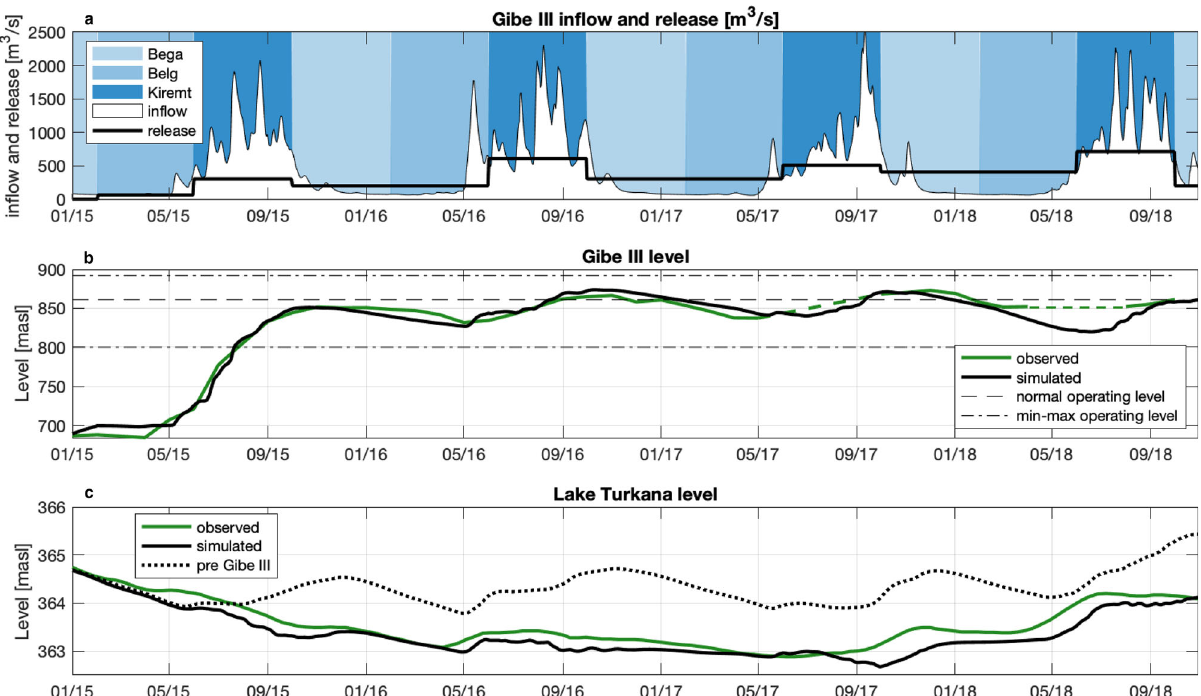
Fig. 2 Reconstructed historical fi lling strategy. a Gibe III reservoir reached its normal operating level within its fi rst two years of operations by impounding the near totality of the 2015 Kiremt season in fl ow, and a signi fi cant fraction of 2016 ’ s. b In the two following years, Gibe III level oscillates around its operational level as a consequence of a release pattern that increases low fl ows and reduces high fl ows with respect to natural Omo hydrology. c Simultaneously, Lake Turkana suffered a 2-m level drop with respect to a simulation of a scenario in which Gibe III was not built. While the Lake Turkana level trajectory estimated from satellite altimetry is publicly available 64 , we reconstructed the Gibe III level trajectory from Sentinel 2 image classi fi cation (see “ Methods ”